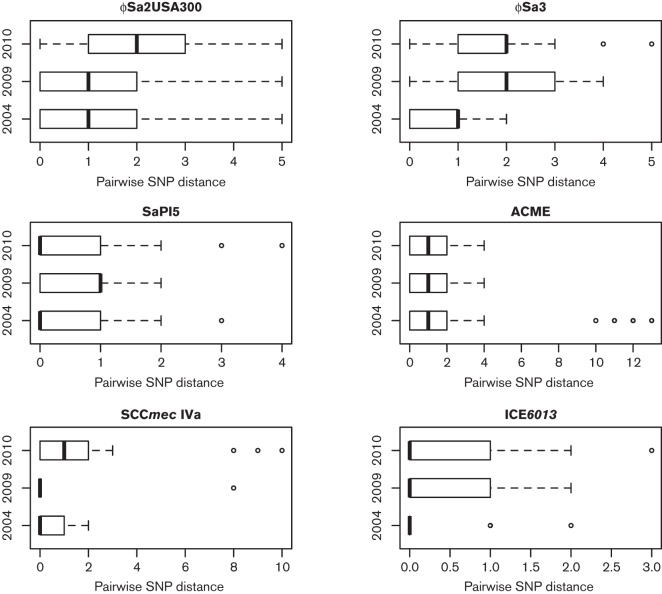
Temporal variation in pairwise SNP distance distributions between chromosomally-inserted MGEs carried by USA300 isolates. Based on isolates derived from healthcare centres selected for temporal analysis (HC1, HC6, HC7, HC10).